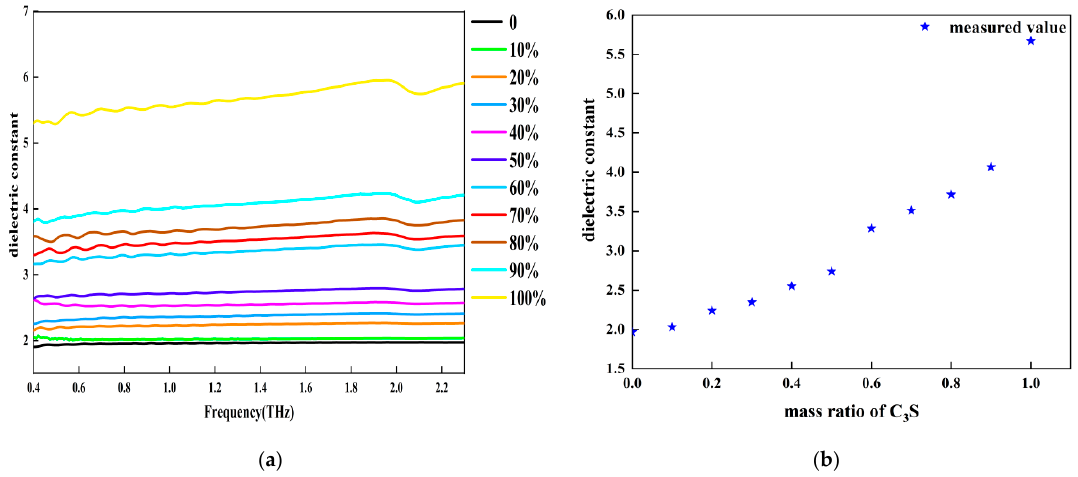
Figure 11. Dielectric constant of a mixture of C 3 S and PE: ( a ) experimental measurement of dielectric spectra of mixtures; ( b ) average dielectric constant in the 0.4–2.3 THz range. To verify the experimental results, we used three EMT models to calculate the die- lectric constant of each sample. The intrinsic dielectric constants of C 3 S and PE were 6.51, 6.61, and 6.73, and 2.17, 2.16, and 2.17, respectively, as determined in Section 5.2. Figure 12 shows comparisons between the measured dielectric constant and the calculated die- lectric constant using the three models. As shown in Figure 12a–c, the calculated values agreed with the measured values. The R-squared values for the MG, BM, and LLL models were 0.9774, 0.9782, and 0.9809, respectively. Using Equation (9), we calculated the rela- tive errors, as shown in Figure 12d, to be 3.86%, 3.30%, and 2.98% for the MG, BM, and LLL models, respectively. Therefore, the LLL model was the best for fitting the THz die- lectric constants of the samples. Both the MG and the B models were derived by assuming that the guest phase was spherical. However, the LLL model did not have this limitation. ploys Taylor approximation [20]. The dielectric contrast between C 3 S and air is relatively small, which may explain why the LLL model performed better than the other two mod- els.